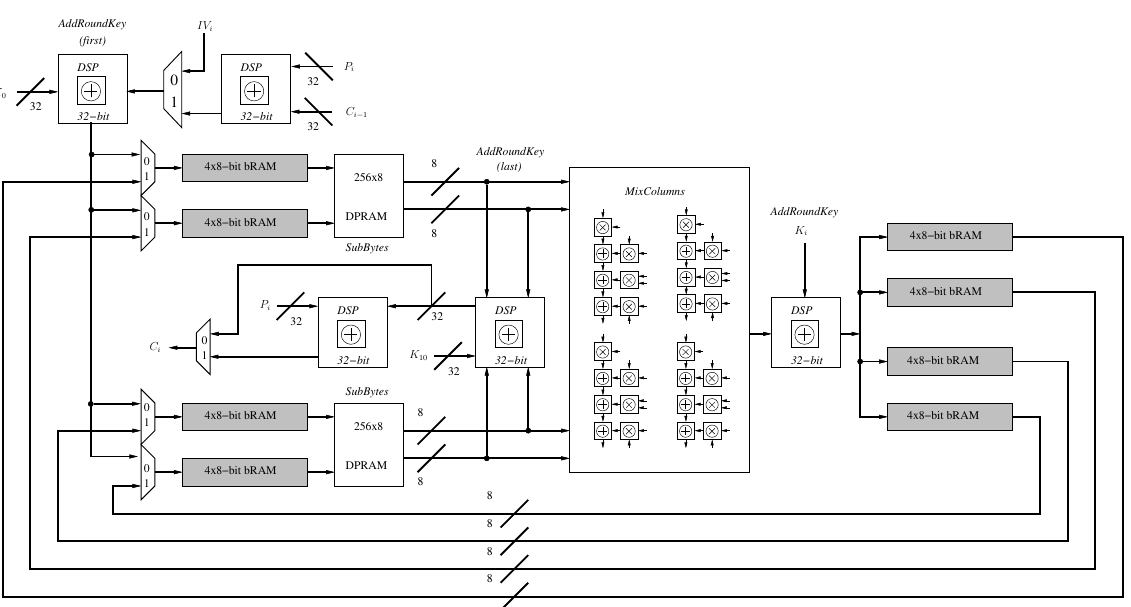
Figure 1. Organization of the proposed AES-CCM architecture.